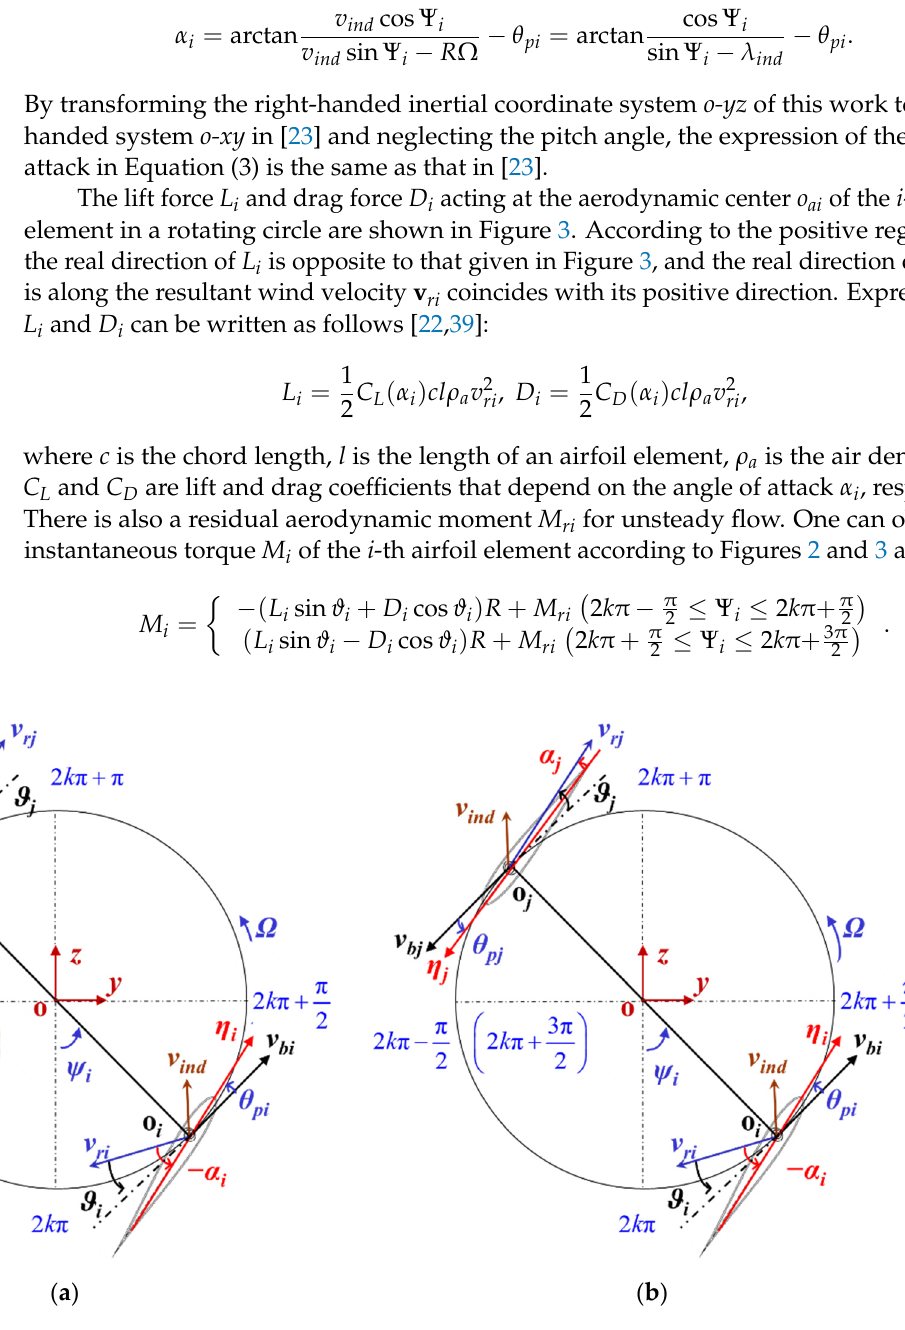
Figure 2. Schematic diagram of resultant wind velocities and angles of attack: ( a ) large positive pitch angles and ( b ) small positive or nonpositive pitch angles in the downwind area.